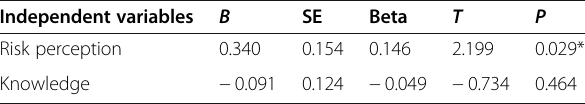
Table 5 Multivariate regression analysis with protective behaviors as a dependent variable Independent variables B SE